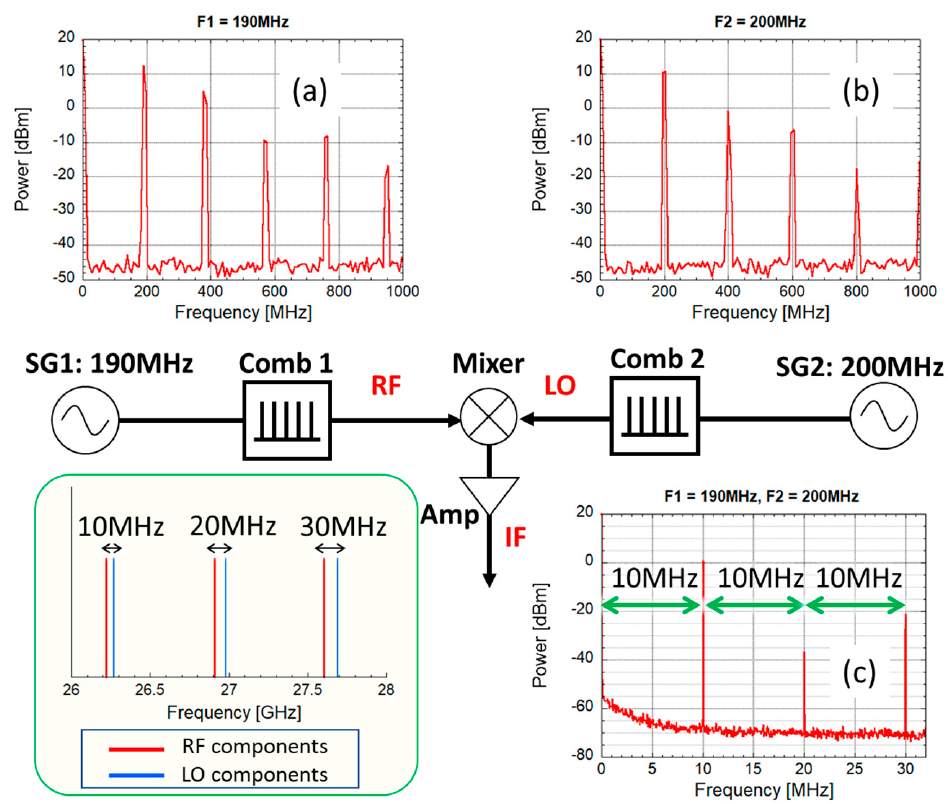
Figure 5. Schematic diagram of dual comb operation concept. Here, signal generators (SGs) of SG1 (190 MHz) and SG2 (200 MHz) are used as clocks for comb generation for RF and LO, respectively. Frequency spectra: ( a ) RF, ( b ) LO, and ( c ) IF signals observed in this conceptual test.